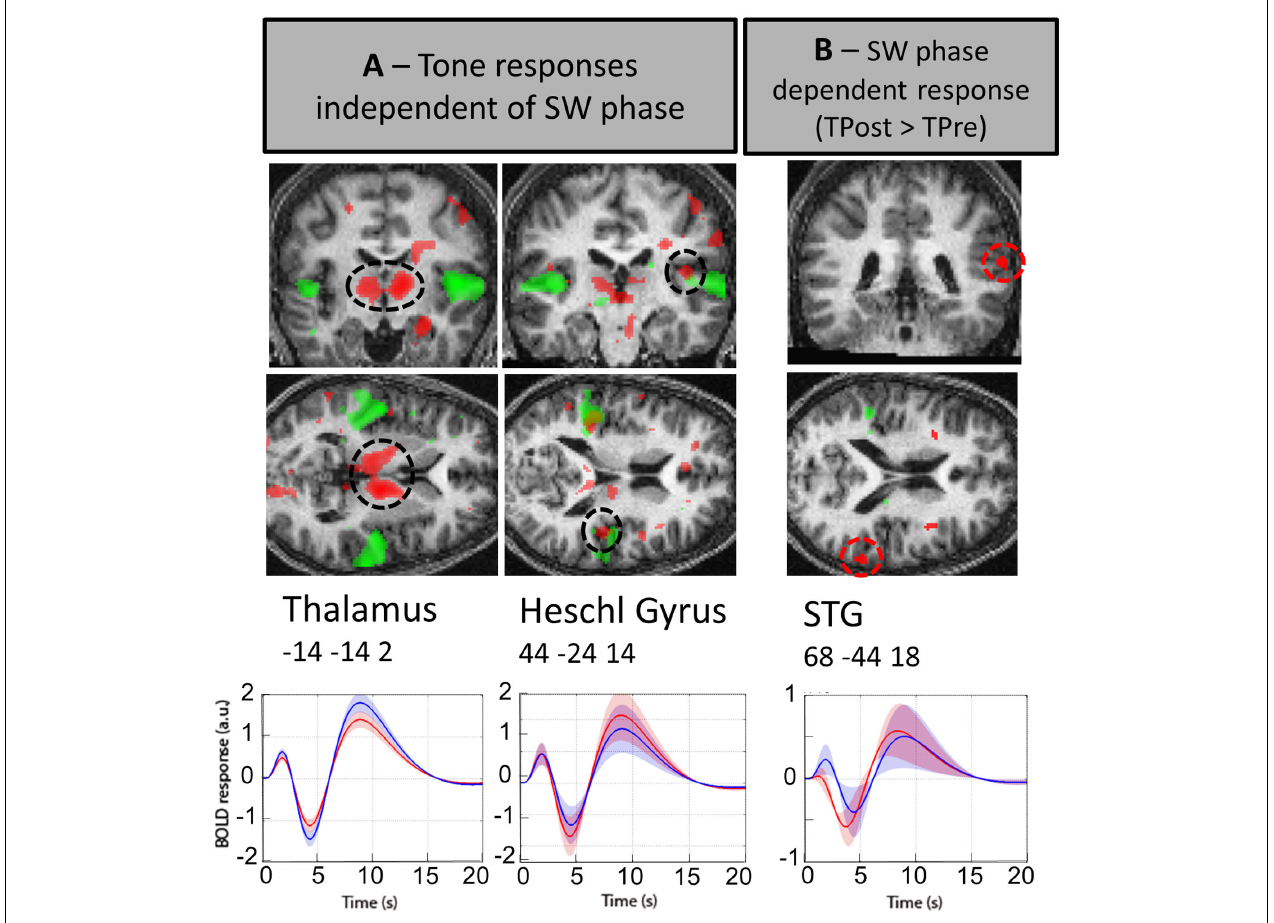
Heschl gyrus (middle panel), and the STG (right panel) associated with sounds delivered after (TPost, blue) or before (TPre, red) the SW-peak negativity.The curves correspond to the mean and the shaded areas to the SEM. Additionally, the waking responses to tones (TW) are shown in green for illustrative purposes. Random effect results ( n = 13) are displayed on an individual structural image (displayed at p < 0.001,